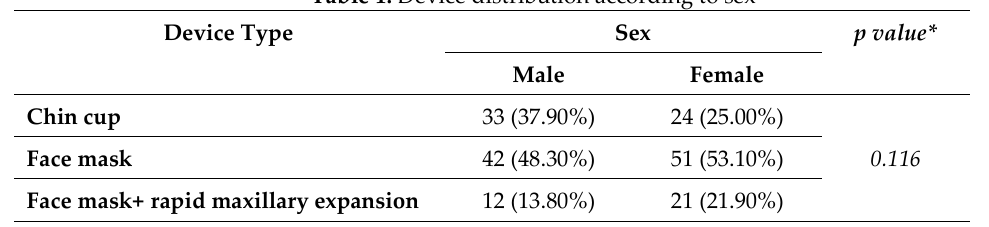
Table 1: Device distribution according to sex